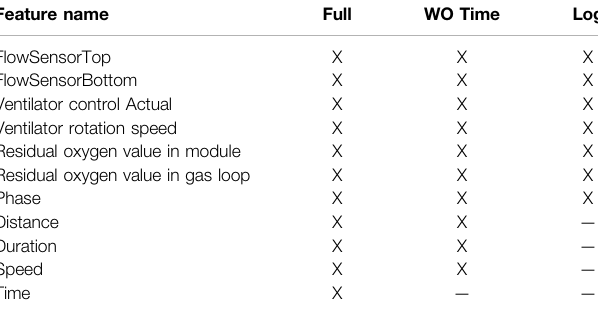
TABLE 5 | Three different input feature sets ( “ Full ” , “ Without Time ” , and “ Log Data ” ) that were used to train the XGBoost